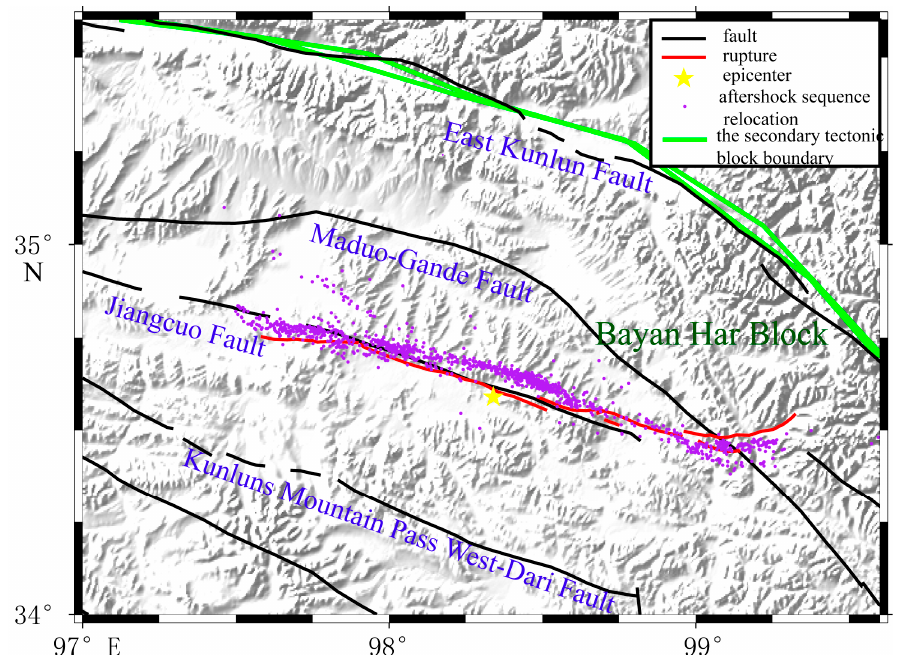
Figure 8. The surrounding faults and the aftershocks relocation of the 2021 Maduo M S 7.4 earthquake: the yellow pentagram represents the location of the epicenter of the 2021 Maduo M S 7.4 earthquake, the purple dot represents the aftershocks sequence relocation of the 2021 Maduo M S 7.4 earthquake, the green line represents the secondary tectonic block boundary, and the black line represents the faults around the epicenter, the red line represents the surface rupture of the 2021 Maduo M S 7.4 earthquake.